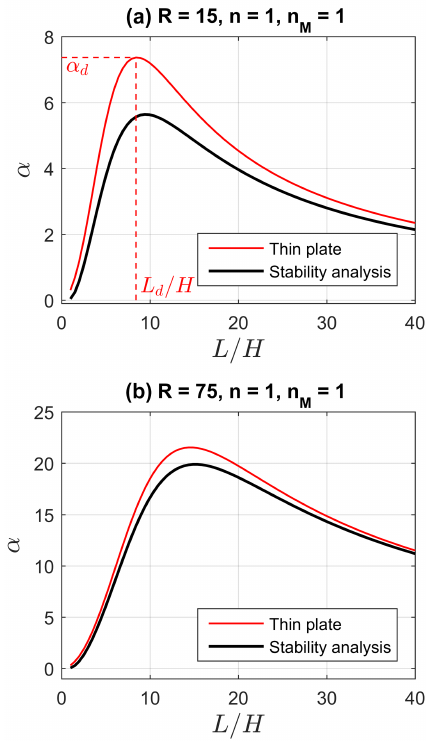
Figure 12. Dimensionless amplification rate, α , vs. wavelength to thickness ratio, L/H , for linear viscous layer and embedding medium (power-law exponent of layer and matrix n , n M = 1) and a viscosity ratio R = 15 (a) and R = 75 (b) . Approximate results are based on the thin-plate approach (Eq. 12) and exact results (for in- finitesimal amplitudes) are based on the stability analysis (Eq. 17). As an example, in (a) the dominant wavelength to thickness ratio, L d /H , and the corresponding maximal dimensionless amplification rate, α d , are also indicated for the thin-plate